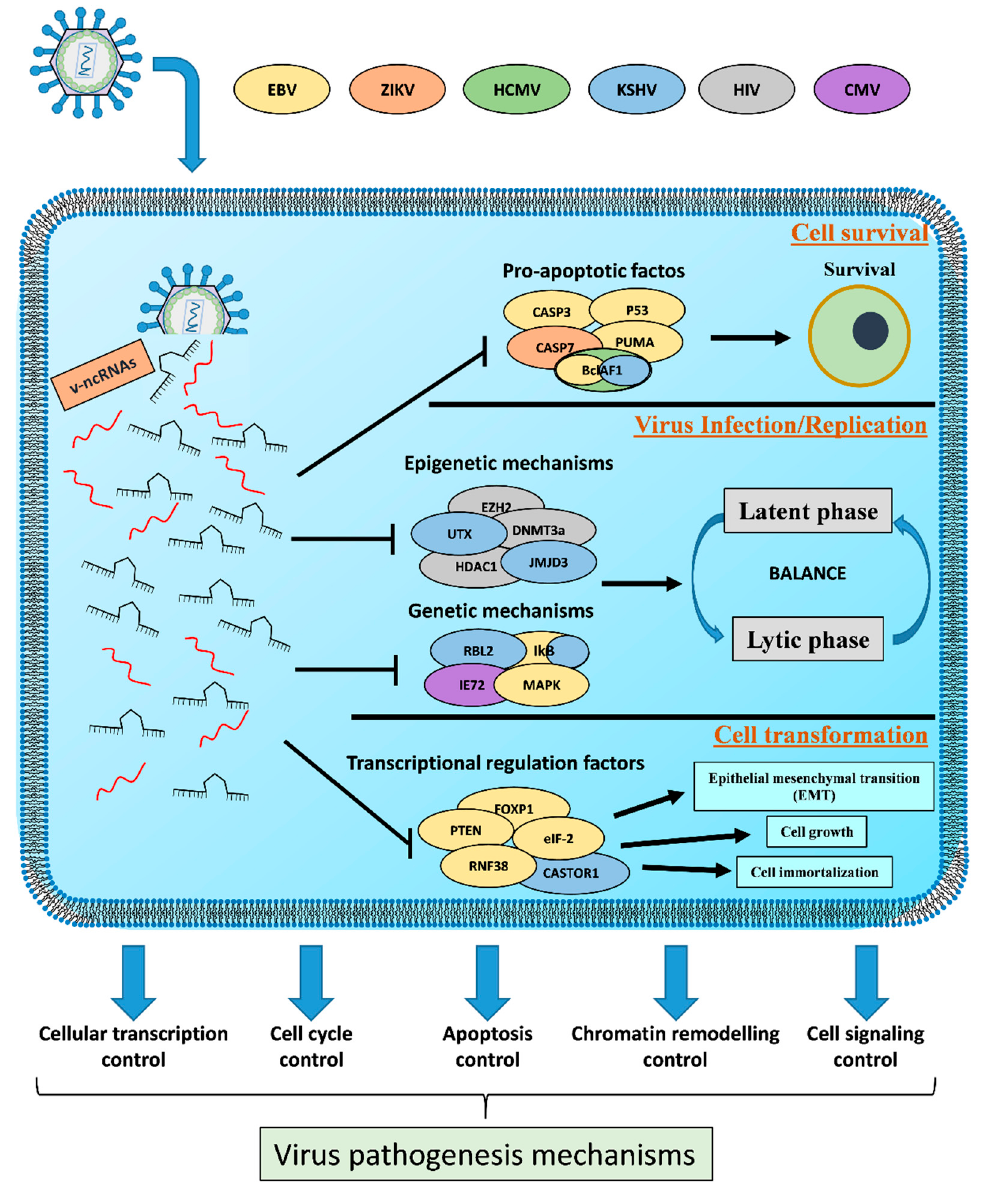
Figure 2. Role of v-ncRNAs in the virus pathogenesis mechanisms. V-ncRNAs act as fine regulators between the latent and lytic phase and as regulators of both survival and cell transformation. The control of these host physiological processes contribute to virus replication/propagation and cell pathogenesis.